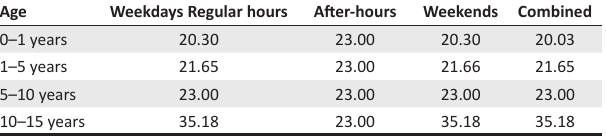
TABLE 5: 75th percentile Computed Tomography Dose Index (mGy) of vol of data distribution, categorised for time and age for computed tomography brain examinations at Rahima Moosa Mother and Child Hospital ( n =